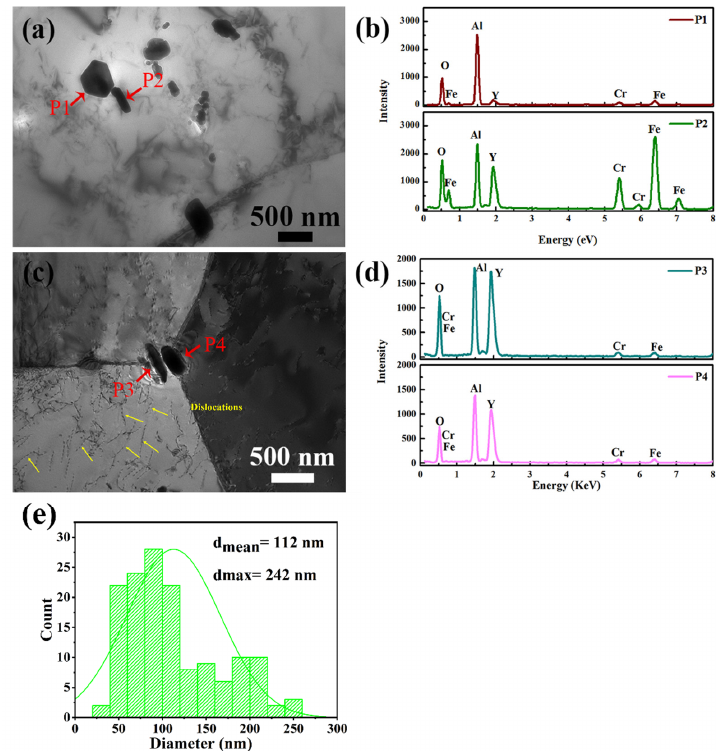
Figure 6. TEM images of ( a ) precipitates within the grains and ( c ) at grain boundaries in the as-TMTed sample; ( b ) and ( d ) EDS spectra of the arrowed precipitates in ( a ) and ( c ) for the as-TMTed sample, respectively, ( e ) the diameter statistical histogram of oxides in the as-TMTed sample. Figure 6a,c shows that there were dispersed precipitates within the grains and at the grain boundaries, with an average size of about 112 nm (as shown in Figure 6e). The EDS results of precipitates (pointed by the red arrows in Figure 6a,c) are shown in Figure 6b,d, respectively. Not only aluminum oxide particles (P1), but also Y-Al-O particles (P2,P3,P4) were found at the boundaries. Notably, the large and continuous aluminum oxide disap- peared, which correspond to Figure 5a,b. In addition, extensive dislocations (pointed by yellow arrows) were observed around the grain boundaries as shown in Figure 6c. 3.2. Tensile Properties and Fracture Surface Figure 7 shows the yield strength (YS), ultimate tensile strength (UTS), and elonga- tion of the as-HIPed and as-TMTed samples tested at 25 °C. The average UTS of the as- HIPed and as-TMTed alloys was 522 MPa and 658 MPa, respectively. The average YS of the as-HIPed and as-TMTed alloys were 515 MPa and 442 MPa. In addition, the average fracture elongation of the as-HIPed and as-TMTed were 0.5% and 23%. The error bars of YS and UTS in the as-TMTed alloy were smaller than those of the as-HIPed alloys as shown in Figure 7.